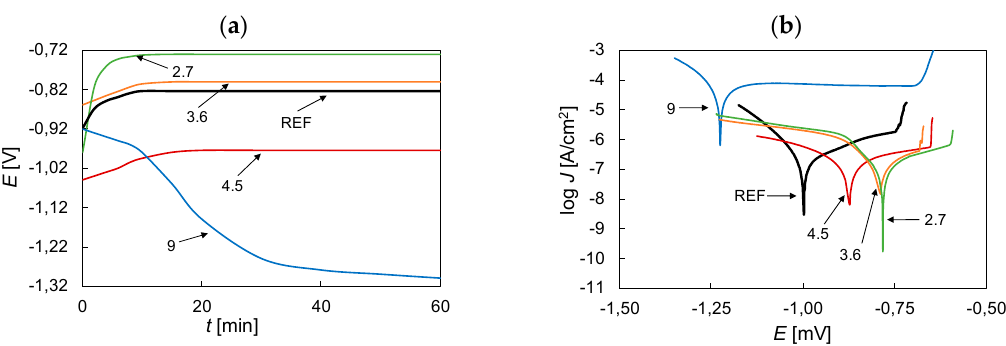
Figure 3. Electrochemical measurement of 5754 aluminum alloy taken in the 3% NaCl solution: ( a ) the potential-time curve and ( b ) selected potentiodynamic curves.